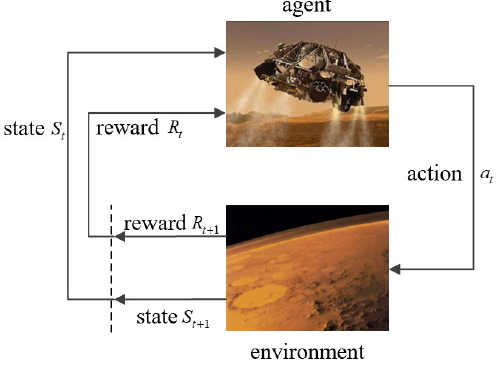
Figure 3. Interaction between agent and